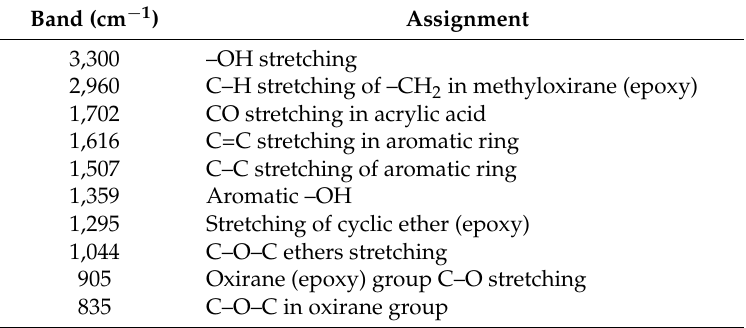
Table 1. Assignment of groups in the FTIR spectrum of the ET3 tannin epoxy acrylate resin.